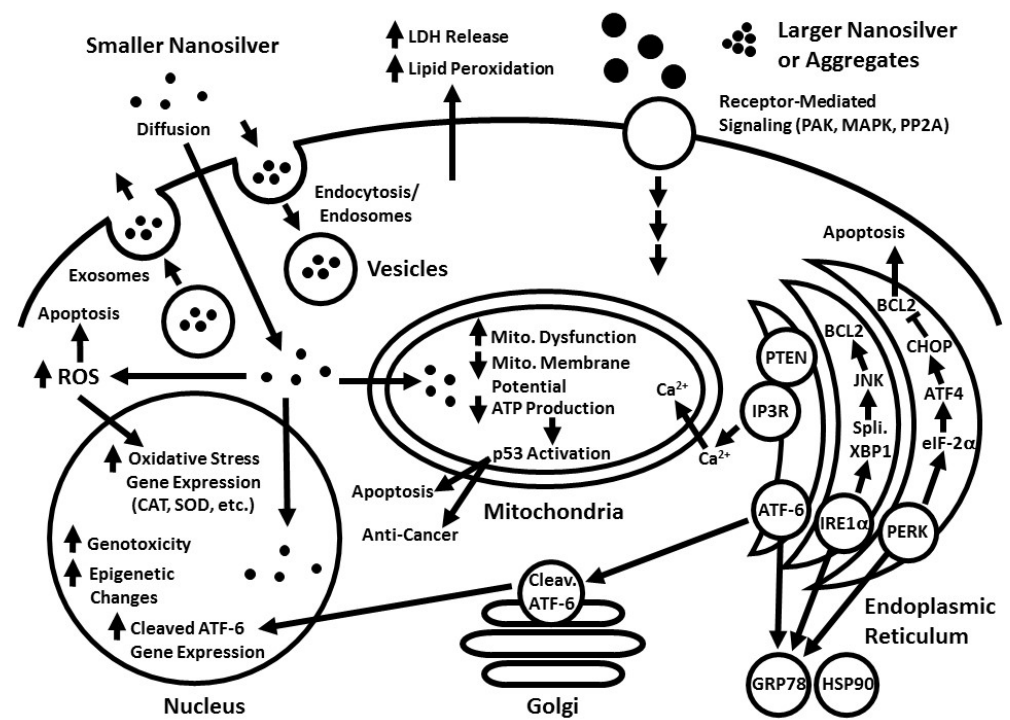
Figure 1. Effects of silver nanoparticles on the cell stress response pathways. Smaller sized nanosilver (~10 nm diameter) enters the cell either through being taken up into endosomes/lysosomes by endocytosis or through simple diffusion across the cell membrane (potentially due to induced lipid peroxidation and disruption of the plasma membrane). Larger sized nanosilver or large aggregates of nanosilver cannot enter the cell by these means, but can instead activate various receptor-mediated signalling mechanisms, such as through PAK, MAPK, and PP2A. Increased lipid peroxidation causes increased LDH release from the cell due to cell membrane damage. Nanosilver treatment results in an increase in reactive oxygen species (ROS), and the extrinsic apoptotic pathway may be induced. The levels of reduced glutathione (GSH), superoxide dismutase (SOD), and catalase (CAT) are